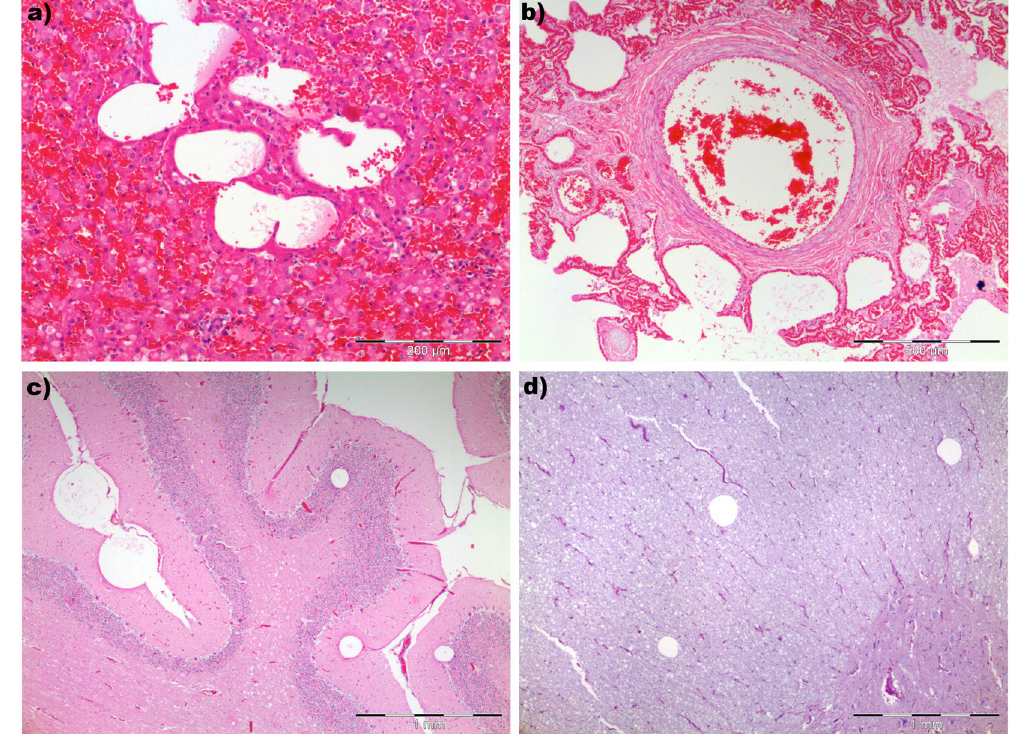
Figure 2. Histopathological findings in two Risso’s dolphins with acute decompressive pathology. Round non- staining spaces among groups of red cells consistent with gas bubbles in liver ( a ), lung ( b ) and cerebellum ( c ). Scattered gas bubbles in the white matter neuroparenchyma of the spinal cord ( d